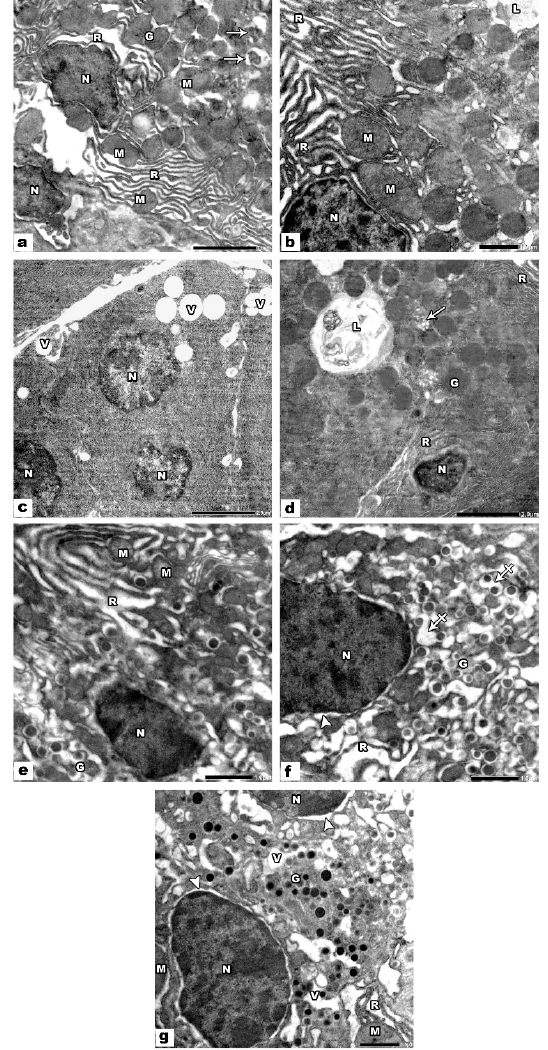
Figure 4. Electron micrographs of VPA treated pancreatic sections. ( a – d ) The pancreatic acini show small dense irregular heterochromatic nuclei (N), dilated disordered rough endoplasmic reticulum (R), swollen mitochondria (M), decreased secretory granules (G) some of them appear degraded (arrows), many cytoplasmic vacuoles (V) and autophagic vacuoles (L). ( e , f ) β cells of the islets show small dense irregular heterochromatic nuclei (N), some nuclei (N) show perinuclear halo (arrowhead), dilated rough endoplasmic reticulum (R), swollen mitochondria (M), increased lucent halo of many of the secretory granules (G) with the fusion of some of them (crossed arrows). ( g ) α cells of the islets show small irregular condensed nuclei (N) with wide perinuclear space (arrowhead), vacuolated cytoplasm (V), dilated disordered rER (R), swollen mitochondria (M), and secretory granules (G).